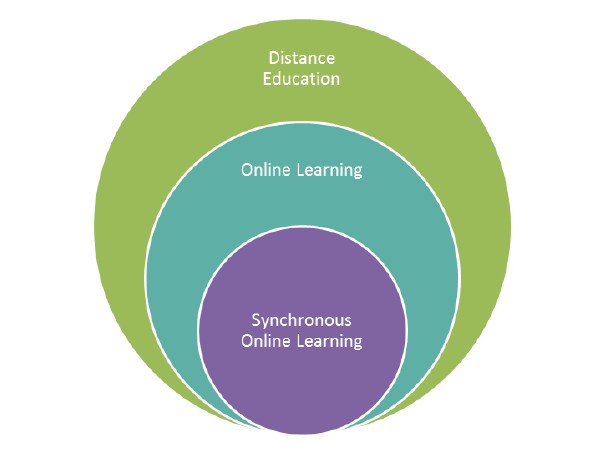
Synchronous Online Learning Conceptual